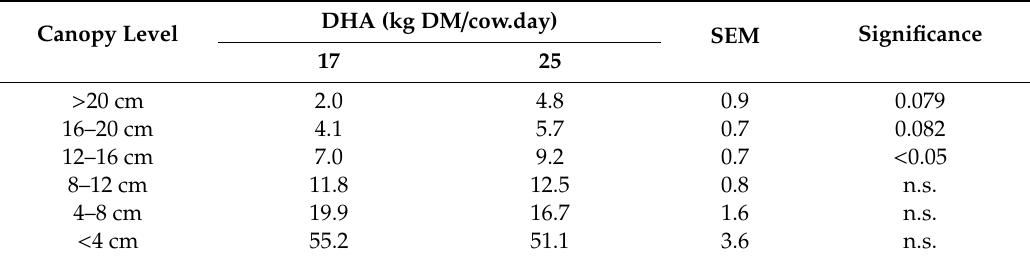
Table 2. E ff ect of daily herbage allowance (DHA) on the vertical distribution of dry matter (DM) herbage mass from the top of the canopy to the ground level.